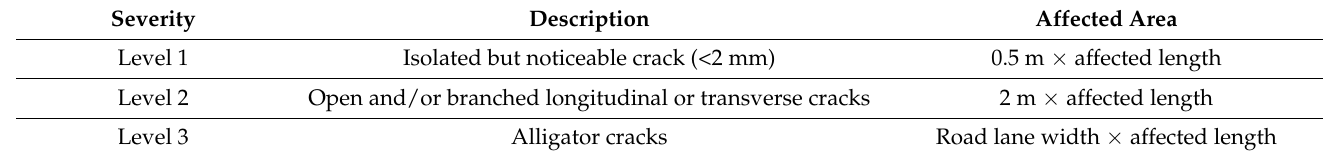
Table 4. Cracking level characterization as proposed by the company’s road analysis experts.